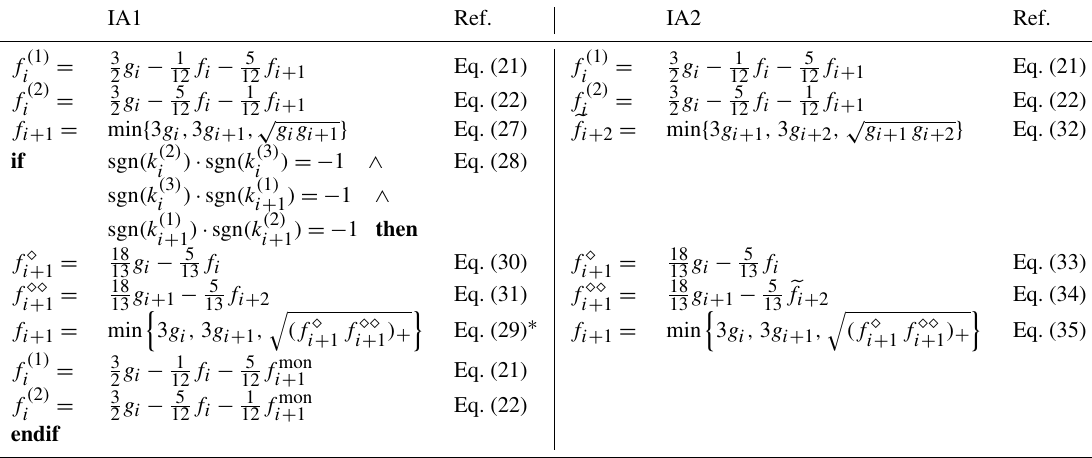
Figure 9. Illustration of the basic IA0 algorithm in (a) , with the additional monotonicity filter in algorithm IA1 in (b) and the directly implemented filter in the algorithm IA2 in (c) . The original precipitation rate g is shown in green with a 3-hourly resolution. The IA0- interpolated data f on the new sub-grid with 1-hourly resolution are drawn in dark blue. A zero baseline is shown in black. Table 1. Overview of the two algorithms IA1 and IA2. IA1